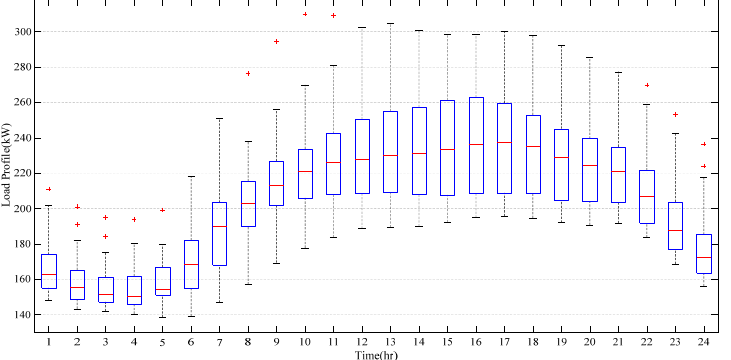
Appl. Sci. 2019 , 9 , x FOR PEER REVIEW Figure 5. The boxplot of electric vehicles load demand. Figure 5. The boxplot of electric vehicles load demand.